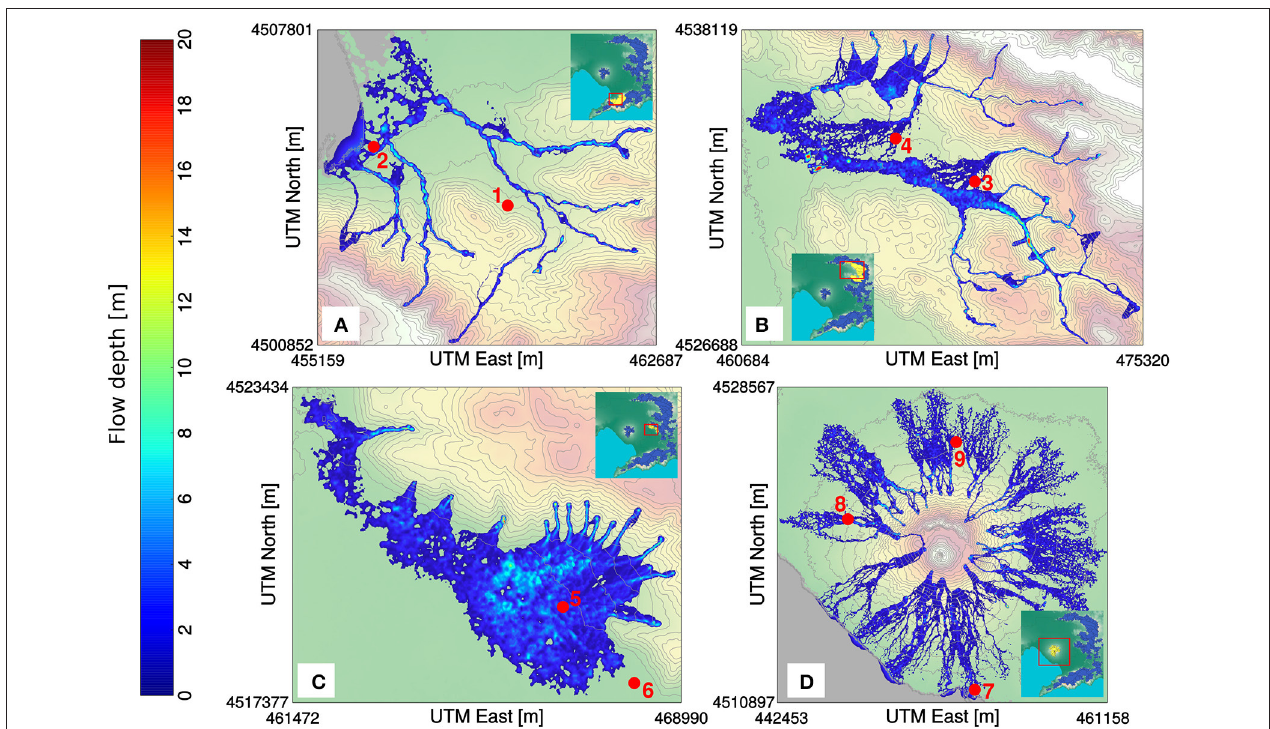
FIGURE 9 | Hazard footprints of flow depth for rain-triggered lahars at four selected locations (simulation groups) on Somma-Vesuvius and surroundings (Italy) computed with the deterministic lahar model LaharFlow . The location of the catchments belonging to each simulation group is given in yellow within the inset of each plot (the red boxes in the insets indicate the limits of each zoomed map): (A) simulation group 03, (B) simulation group 19–20, (C) simulation group 22, (D) simulation group 24. The locations of some villages are given by the red points in the different maps: (1) Gragnano, (2) Castellammare di Stabia, (3) Mugnano di Cardinale, (4) Avella, (5) Episcopio, (6) Sarno, (7) Torre Annunziata, (8) San Sebastiano al Vesuvio, (9) Somma